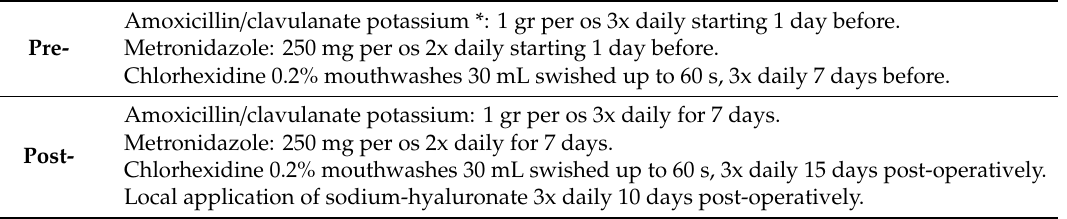
Table 2. Peri-operative pharmacological